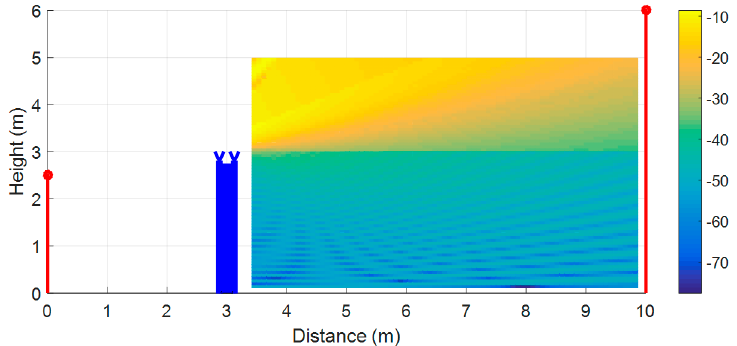
Figure 23. Attenuation map at 1500 Hz at the ‘ambulance’ location. Barrier with the ‘Y–Y’ cap and 3 m height.